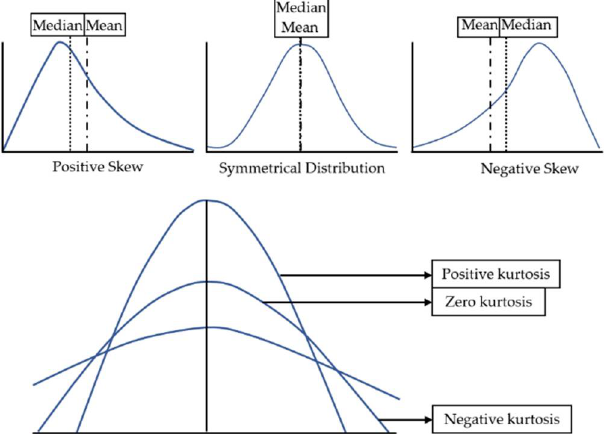
Figure 4. Definition of the possible types of skew and kurtosis in a dataset distribution. Graphical Figure4. Definitionofthepossibletypesofskewandkurtosisinadatasetdistribution. explanation.